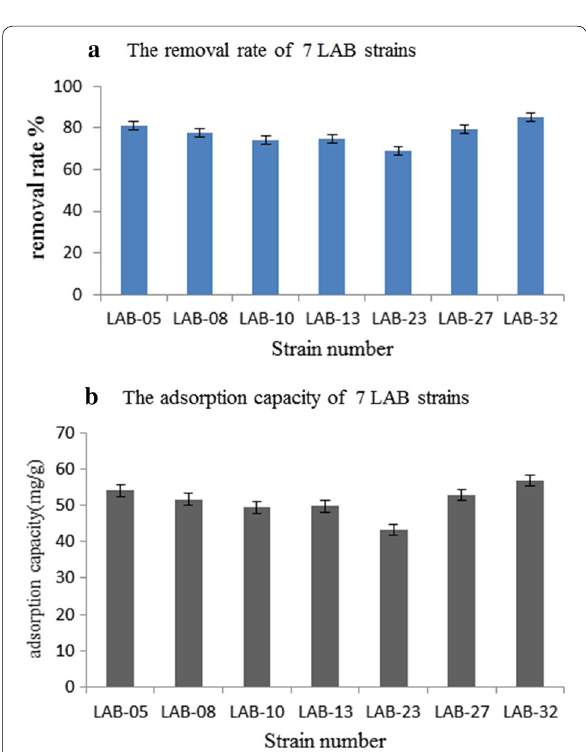
Fig. 4 The removal rate ( a ) and adsorption capacity ( b ) of 7 LAB strains. The blue bar chart represents the removal rate and the gray bar chart represents the adsorption